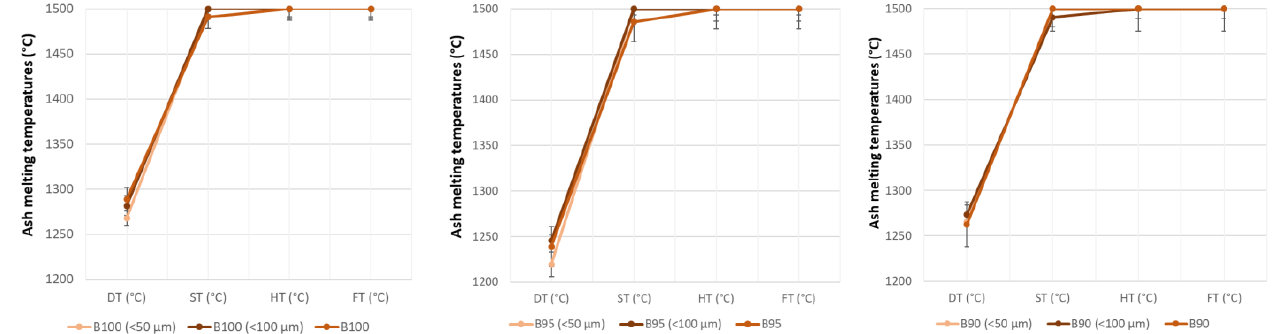
Figure 5. Differences in melting temperatures for beech samples prepared at 815 °C.